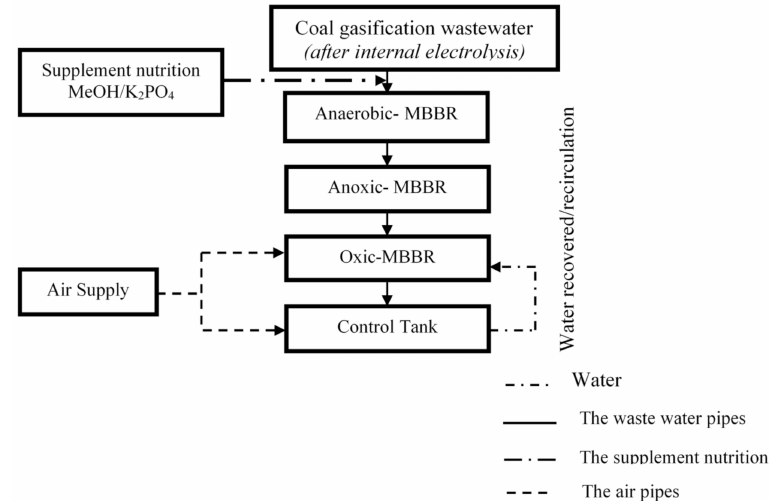
Figure 2. Diagram of A2O-MBBR